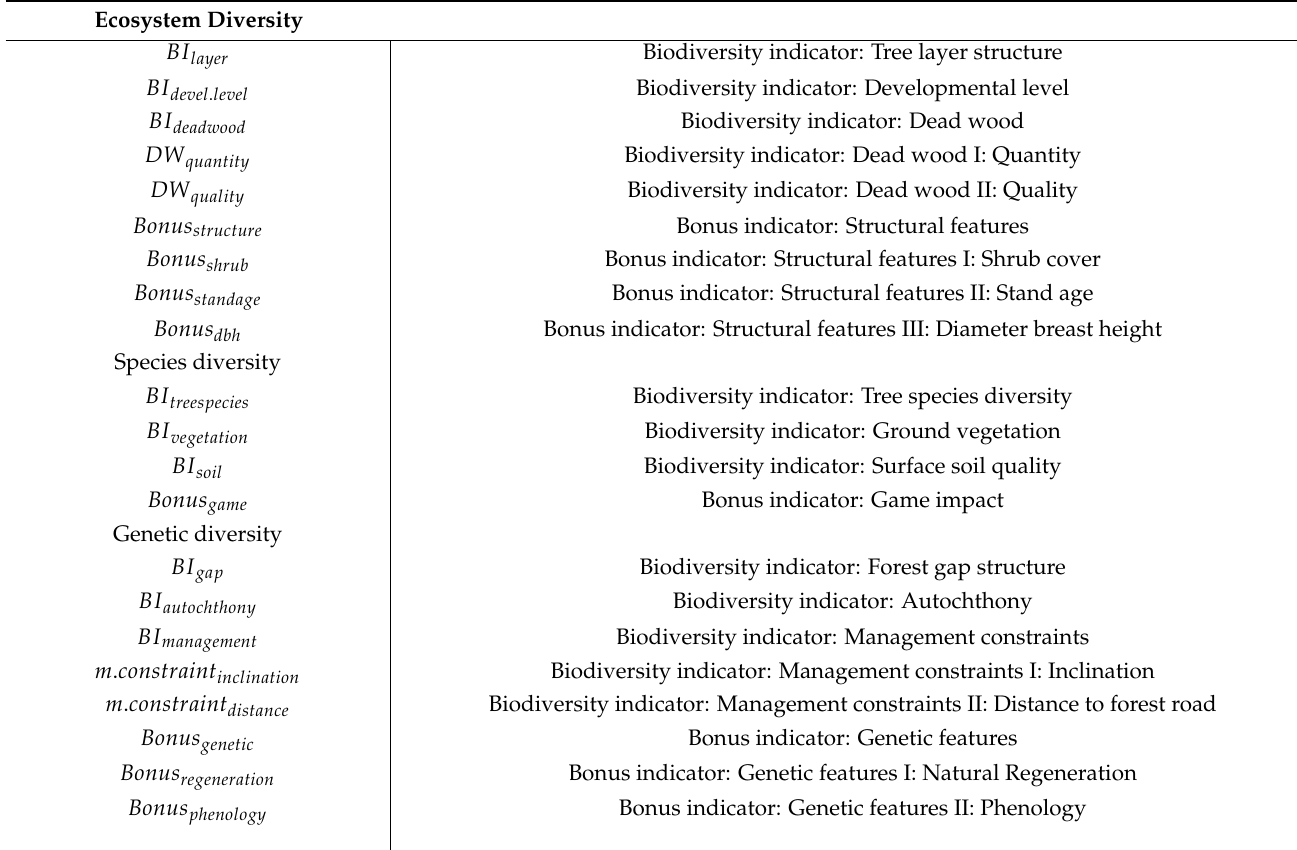
Table A1. Abbreviations of